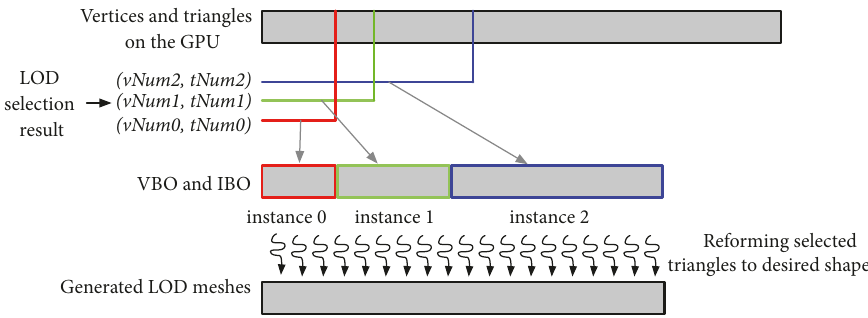
Figure 4: An example illustrating the data structures for storing vertices and triangles of three instances in VBO and IBO, respectively. Those data are stored on the GPU and all data operations are executed in parallel on the GPU. The VBO and IBO store data for all instances that are selected from the array of original vertices and triangles of the source characters. V 𝑁𝑢𝑚 and 𝑡𝑁𝑢𝑚 arrays are the LOD section